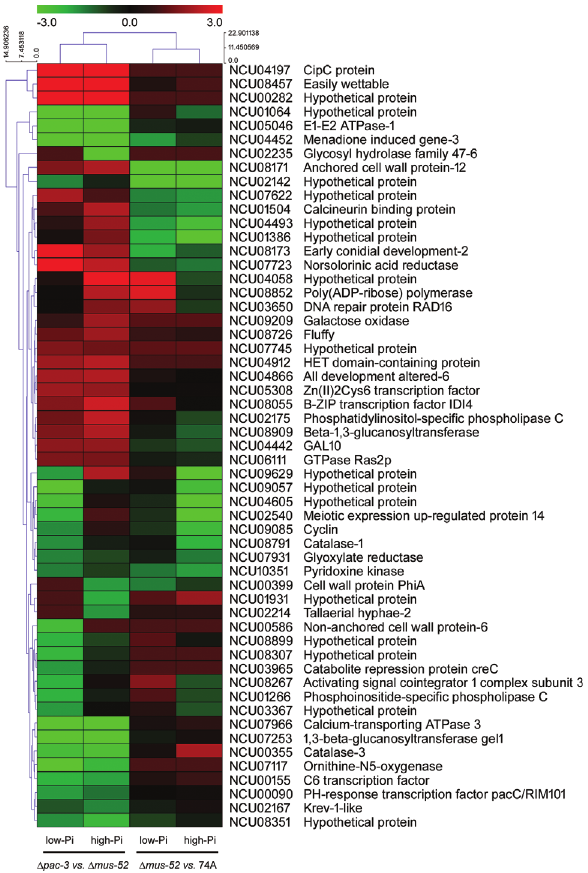
Figure 1 - Heatmap of morphology and development regulation-asso- ciated genes from N. crassa mutants . The hierarchical clustering of ex- pression patterns for the 55 differentially expressed genes identified in the (cid:2) pac-3 (cid:2) mus-52 mutant strain versus (cid:2) mus-52 is compared to the modula- tory pattern observed for the same genes in the (cid:2) mus-52, evaluated in comparison to the wild-type strain. Expression levels were loaded into the MultiExperimentViewer(MeV)andanalyzedusingaverage-linkagehier- archical clustering with a Pearson correlation coefficient distance metric. The intensity of color represents the value of upregulation (red) or downregulation (green) in